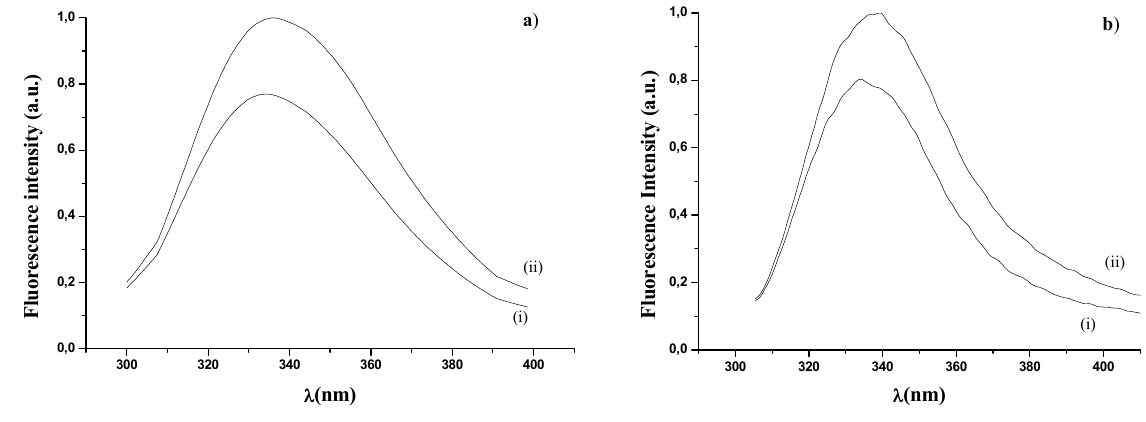
Figure 1. Fluorescence emission spectra ( λ absence (curve i) and in the presence (curve ii) of glucose concentration (2mM); (b)